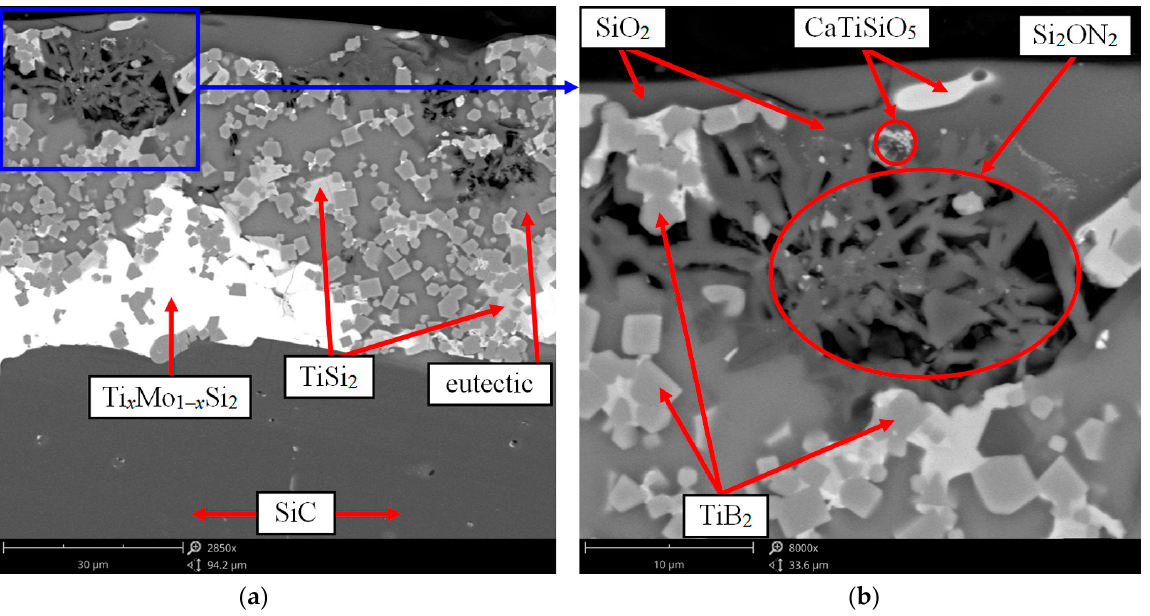
Figure 11. The microstructure of the cross section of the coating containing in situ-formed Si 2 ON 2 fibers after gas-dynamic tests according to the regime shown in Figure 7 а : ( а ) х 2850; ( b ) х 8000.